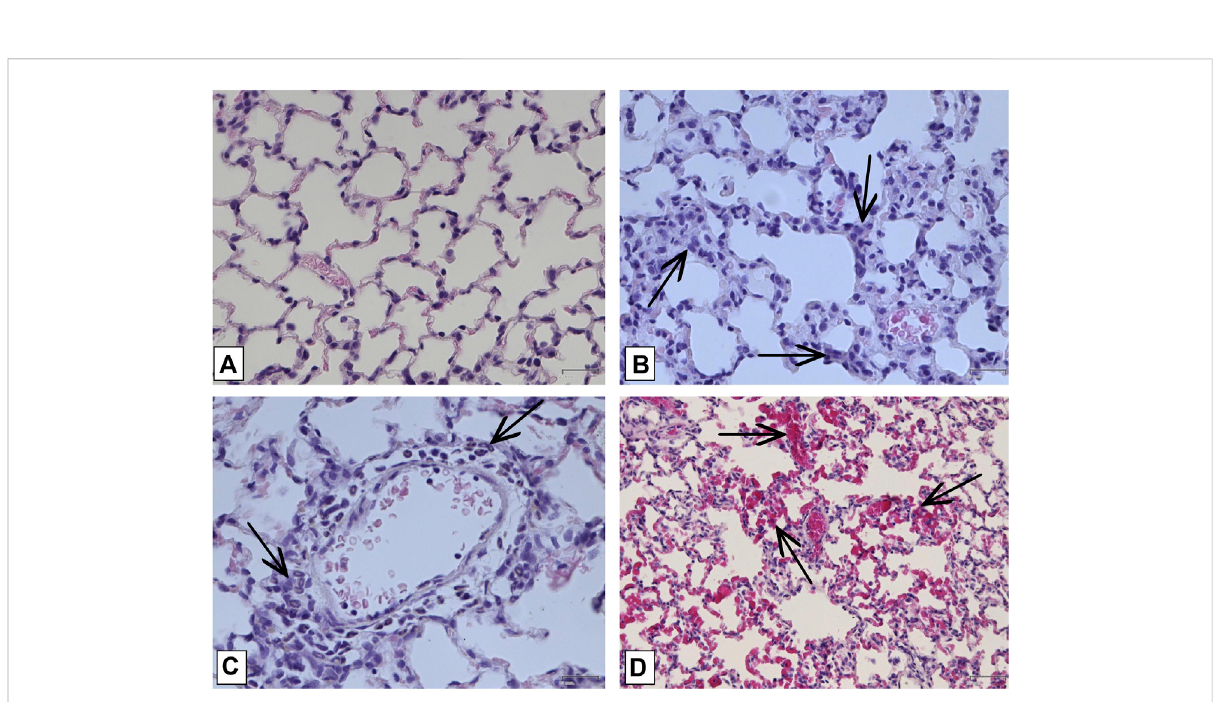
FIGURE 6 Histologic examination of lungs on the 8-th day of study. (A) Lung of intact animal. Magni fi cation y 400; (B) Lymphomacrophagal in fi ltration of theinterstitialspaceMagni fi cation y 400; (C) Perivascularin fi ltrationbyneutrophilsMagni fi cation y 400; (D) CapillaryfullnessMagni fi cation y 200.All described damages are indicated by black